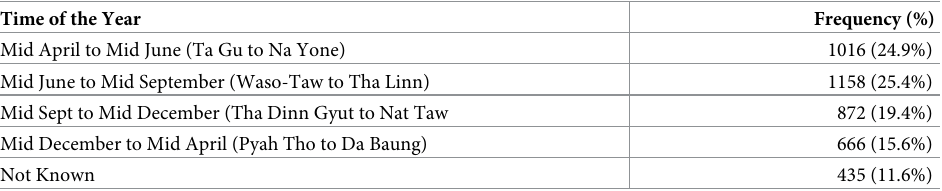
Table 4. Time of the year when snakebite occurs more